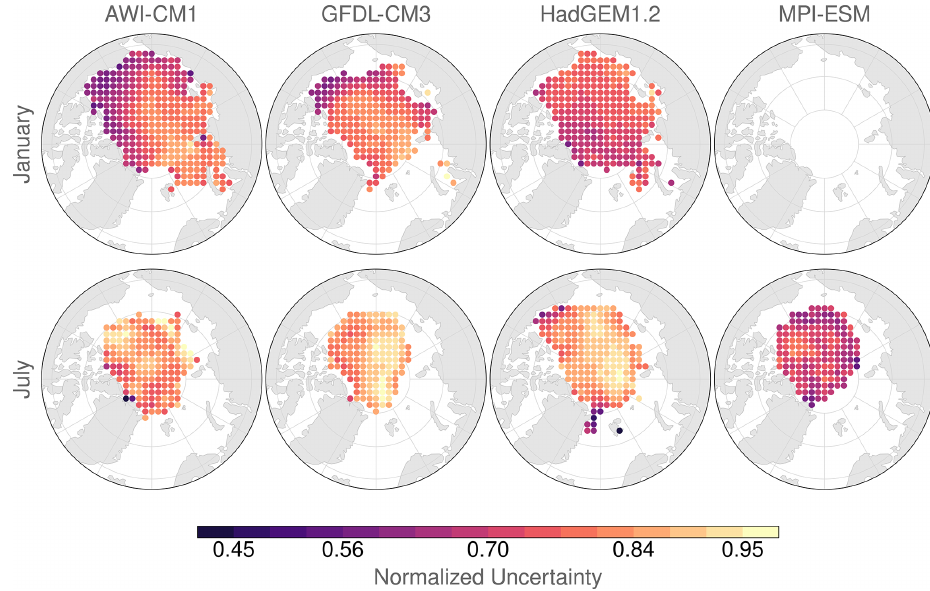
Figure 6. Normalized uncertainty in target position predictions for all initial positions that fulfill the selection criteria 1–3 (see Sect. 2.2) at a 45d lead time. Top row: initializations on 1 January. Bottom row: initializations on 1 July. Note that there are no January initializations for MPI-ESM available.